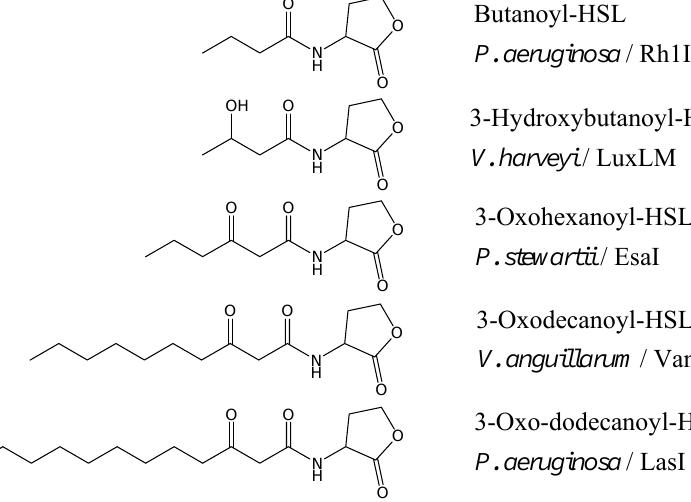
Figure 1. Structure of AHLs found in different Gram-negative bacteria and their signal synthases [16].